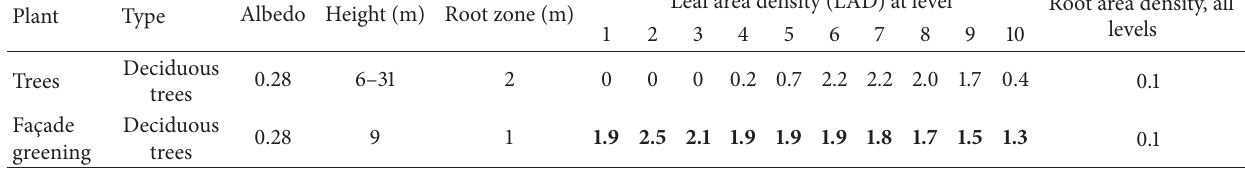
Table 3: Measured leaf area density (LAD) profile of fac¸ade greening (bold) and assumed parameter for the plant database in ENVI-met. Plant Type Albedo Height (m) Root zone (m) Deciduous Trees trees